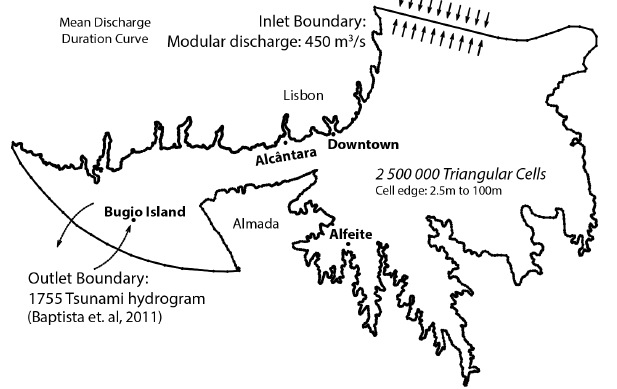
5 Application: A 1755 tsunami in today’s Tagus estuary Fig. 8. Simulation setup concerning inner domain, boundaries and relevant locations along the Tagus estuary. Fig. 8: Simulation setup concerning inner domain, bound- Fig. 9: 1755 Tsunami time series imposed at the Atlantic aries and relevant locations along the Tagus estuary boundary, provided by Baptista et al. (2011). Each cell of the Atlantic outlet is forced to follow the 1755 tsunami level time series, as calculated by Baptista et al. (2011). Historical evidence is one of the most relevant fea- 300